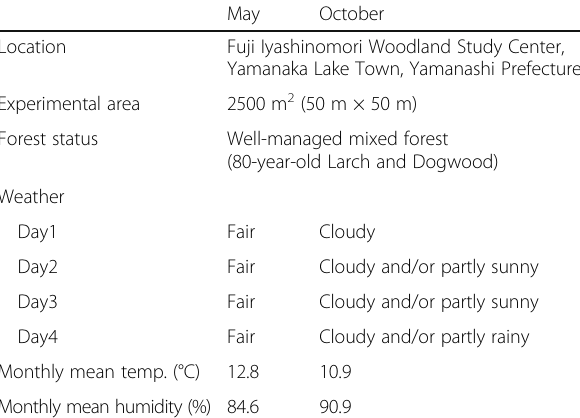
Table 1 Research site characteristics and weather conditions